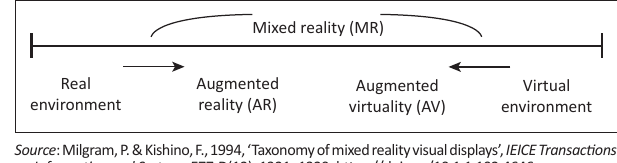
FIGURE 1: Representation of reality – Virtuality continuum.